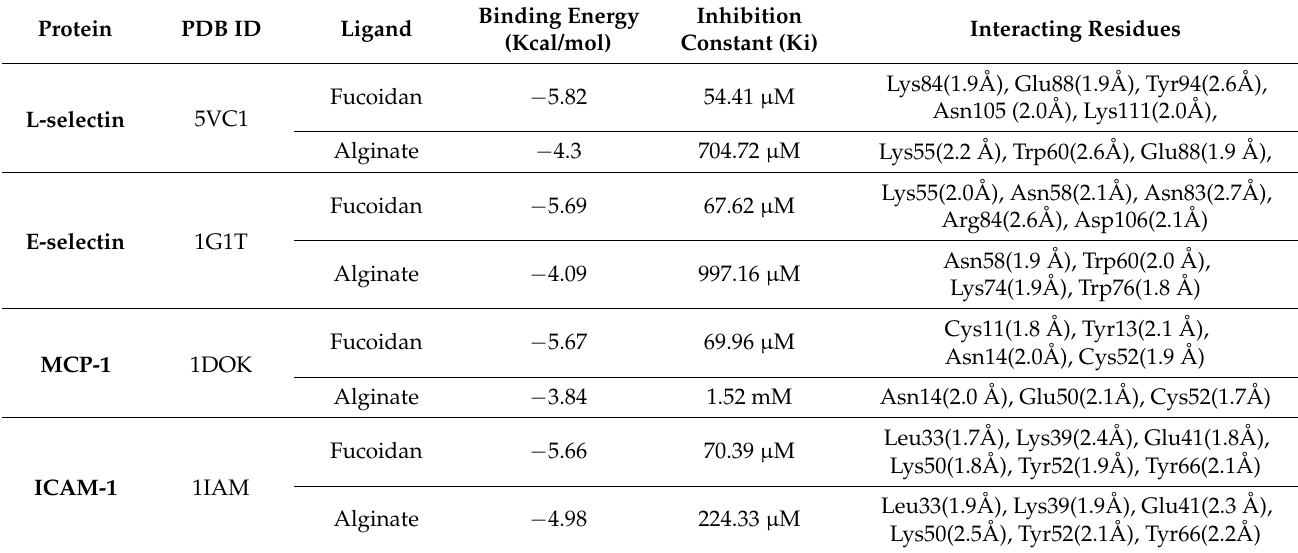
Table 2. AutoDock docking results of marine bioactive compounds (fucoidan and alginate) with inflammatory